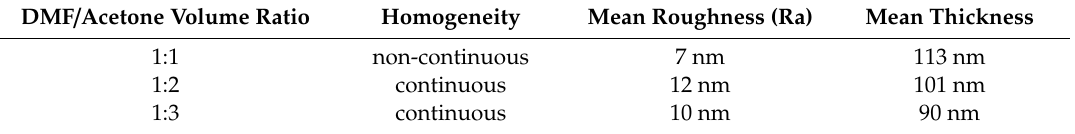
Figure 3. 5 × 5 µ m AFM micrographs showing the morphology AFM images of PVDF thin films with Figure 3. 5 × 5 µm AFM micrographs showing the morphology AFM images of PVDF thin films with di ff erent volume ratio of DMF / acetone in the solution ( a ) 1:1 ( b ) 1:2 ( c ) 1:3. different volume ratio of DMF/acetone in the solution ( a ) 1:1 ( b ) 1:2 ( c ) 1:3. Table 1. Morphology characteristics of the PVDF thin films with di ff erent volume ratio of DMF / Table 1. Morphology characteristics of the PVDF thin films with different volume ratio of